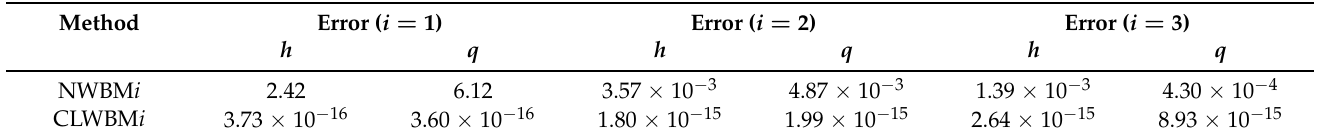
Table 17. Test 4.4. Differences in L 1 -norm with respect to the stationary solution for NWBM i and CLWBM i ( i = 1,2,3) at time t = 2 s for a 100-cell